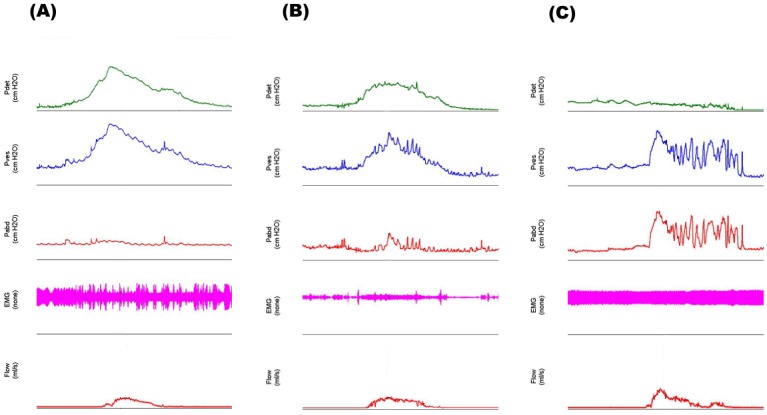
Different patterns of abdominal pressure (pabd) and detrusor pressure (pdet) during the pressure-flow studies (PFSs).(A) Patient voids using detrusor pressure with no meaningful abdominal pressure. (B) Patient voids mainly using detrusor pressure but with the addition of abdominal pressure. (C) Patient voids predominantly by abdominal pressure (abdominal straining). EMG = electromylography, pves = vesical pressure.